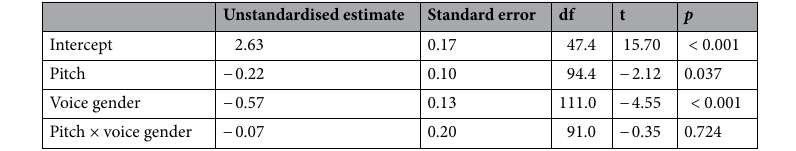
Table 8. Results of our analysis of aggressiveness ratings in Study 2.